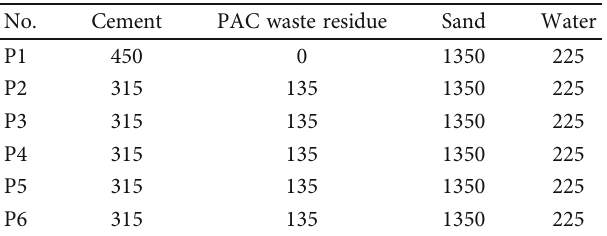
Table 4: Mix proportion of PACRM with di ff erent particle sizes (kg · m -3 ).